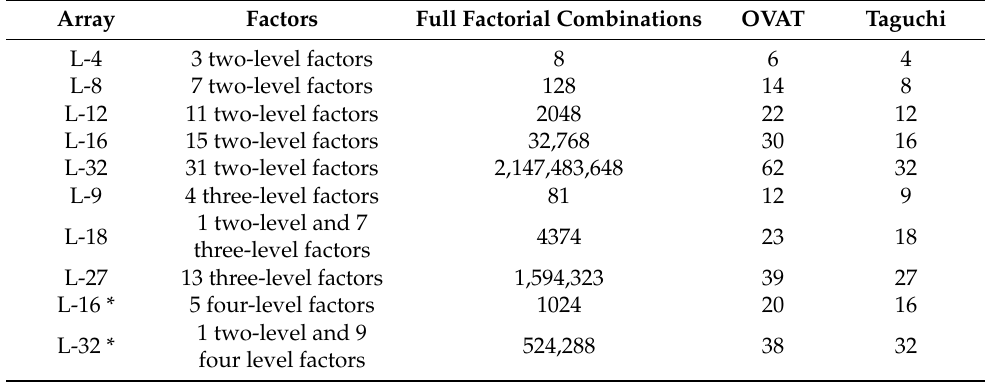
Table 4. Taguchi orthogonal